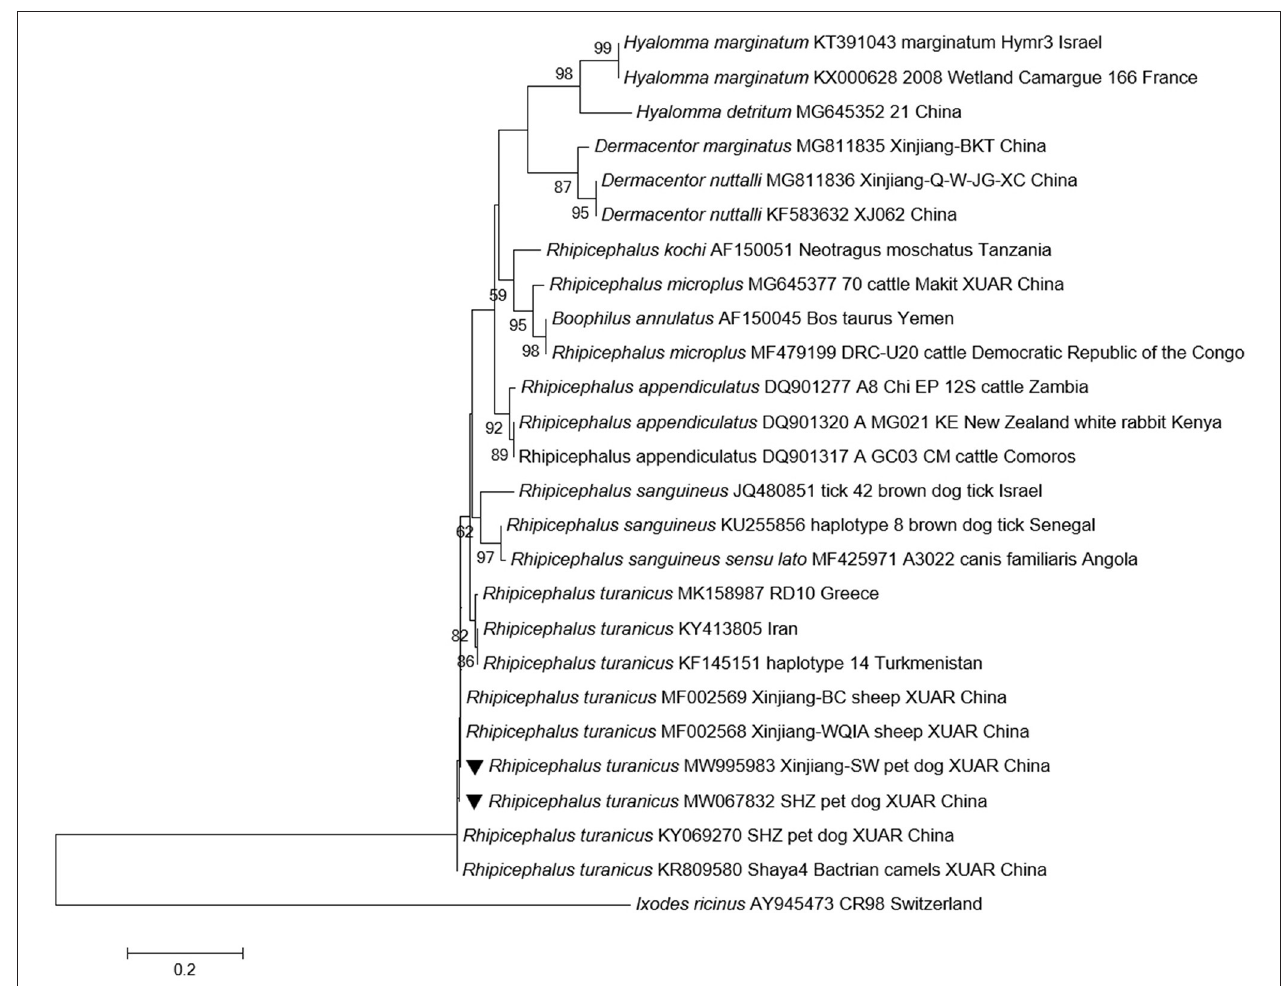
FIGURE 1 | Phylogenetic tree based on 12S rRNA sequences of ticks collected from pet dogs. New sequences obtained in this study are indicated by black triangles.